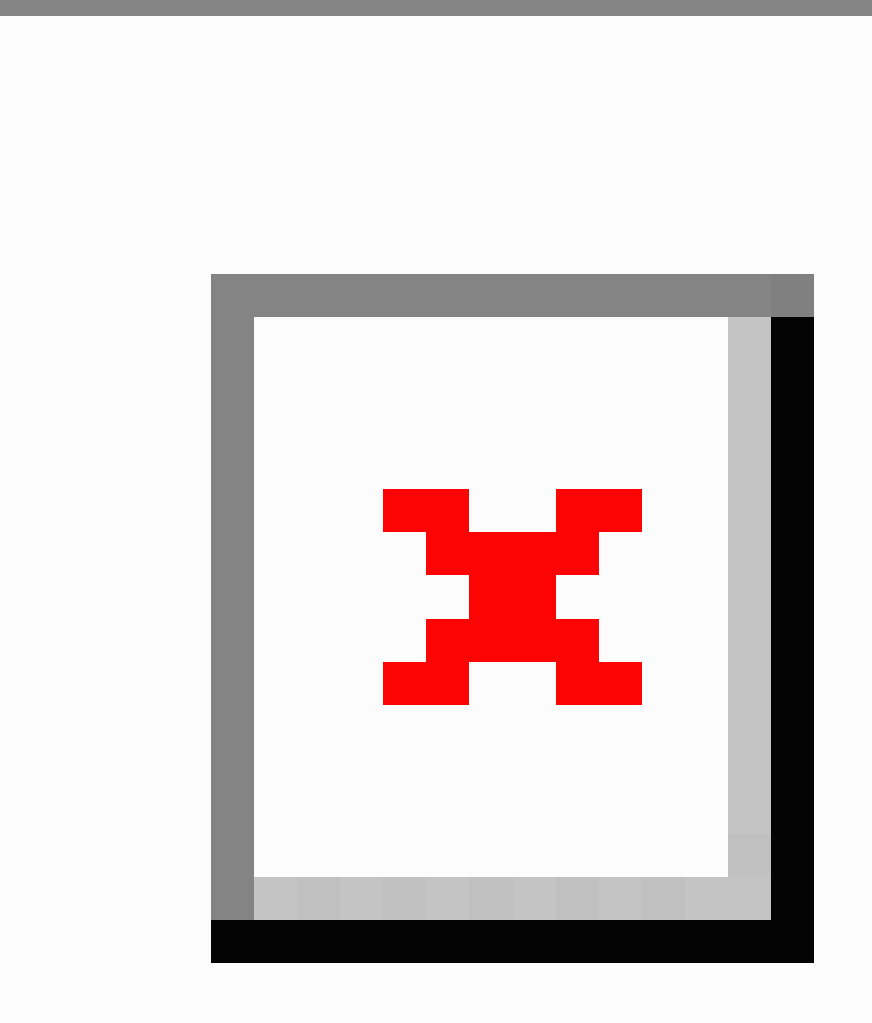
Figure 2. Picture Me Smokefree Facebook landing